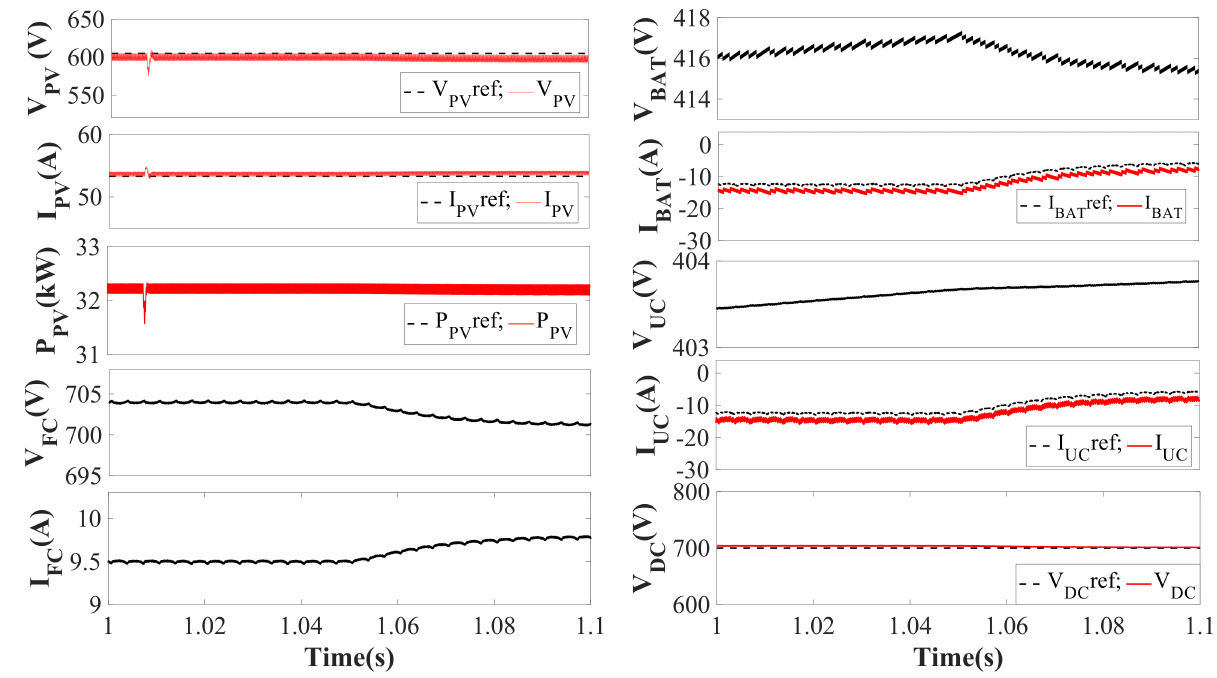
Figure 11. Dynamic performance during a fixed power mode of V PV , I PV , P PV ,V FC , I FC ,V Bat , I Bat , V UC , I UC , and V DC